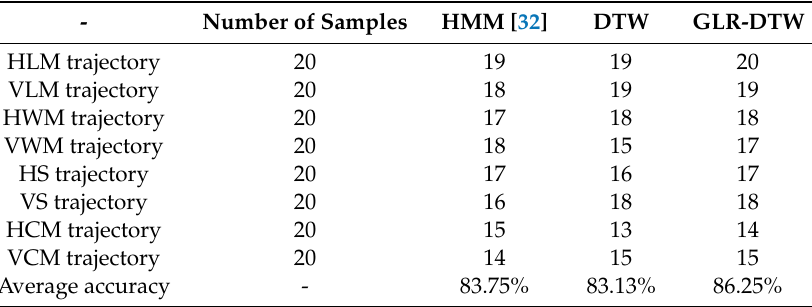
Table 3. The comparison of correct recognition number.